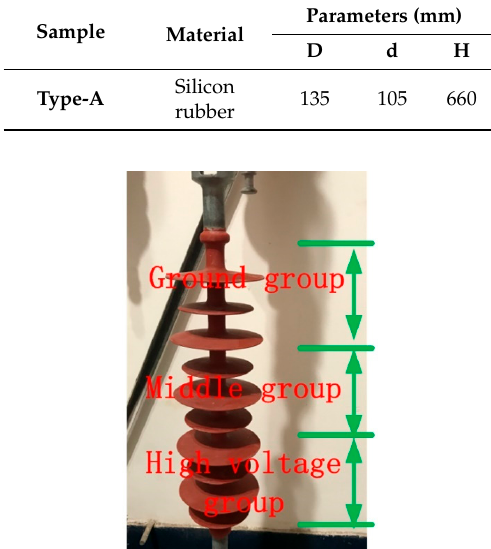
Table 1. Contamination degree and non-uniformity results for field operating insulators.